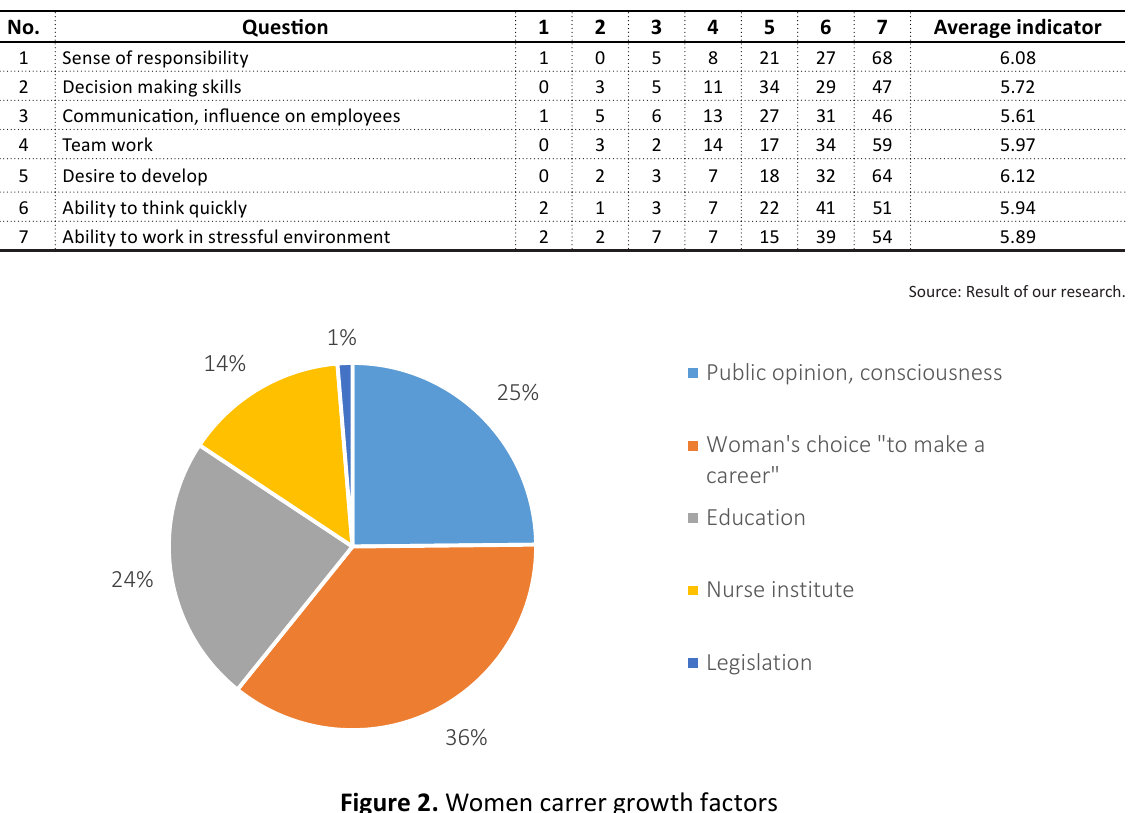
Table 2. The characteristic features of the employed women are evaluated by 7-point system (1 point – very bad; 7 points – very good)